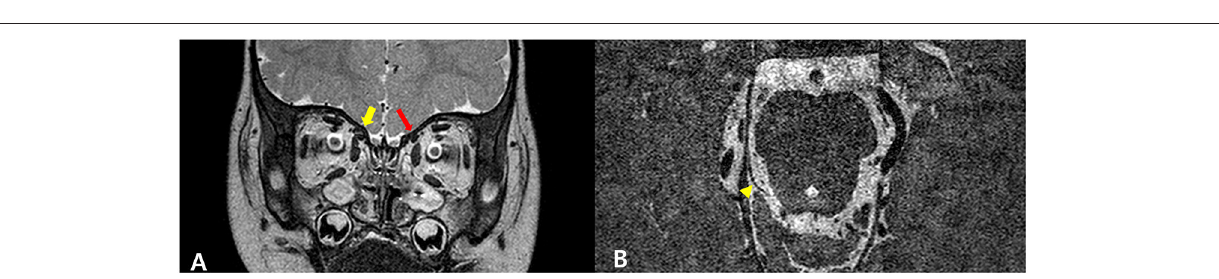
FIGURE 4 | Hypoplasia of the left superior oblique muscle and an absence of the left fourth cranial nerve. Coronal T2-weighted orbital image showing that the left superior oblique muscle (red arrow) is smaller than the right (yellow arrow), suggesting hypoplasia (A) . A high-resolution image shows that the right fourth cranial nerve (arrow) is well-identified; however, the left fourth cranial nerve is not visible (B)